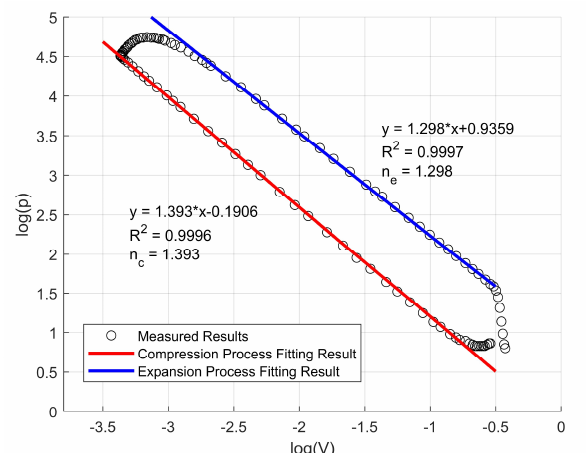
Figure 15. Relationship between log(V) and log(p) and linear fitting result for the compression and expansion process.